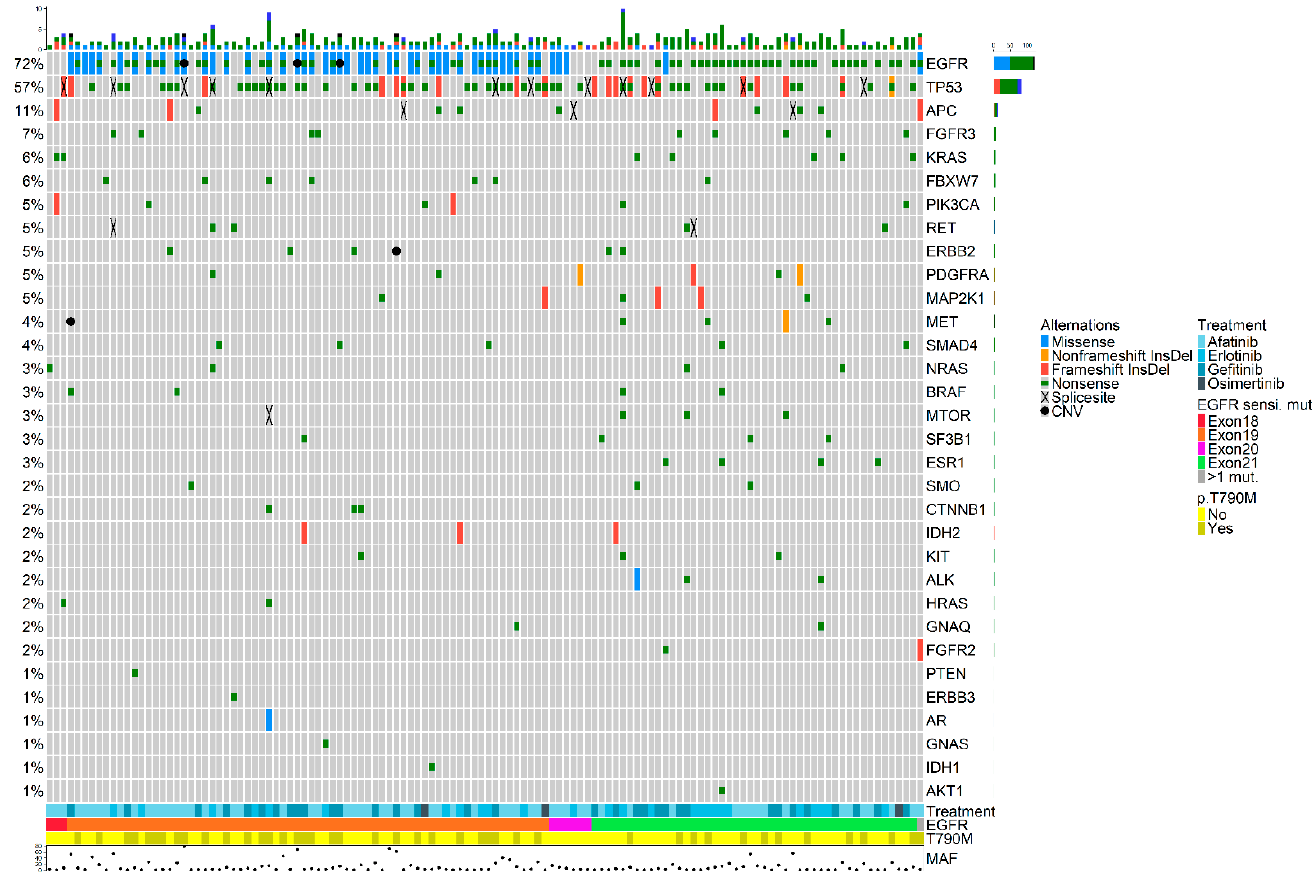
Figure 1. OncoPrint plot showing the distribution of genomic alterations detected in the plasma samples collected upon disease progression. Overview of genomic alterations (legend) in particular genes (rows) for each sample (columns). Missense mutations, non-frameshift deletions or insertions, frameshift deletions or insertions, nonsense mutations, splice site mutations, and CNVs are shown as green rectangles, blue rectangles, red rectangles, black crosses, orange rectangles, and a black dots, respectively. At the bottom of the plot, the following features are presented: first-line EGFR -TKI, type of original EGFR -sensitizing mutation, and detection of the p.T790M resistance mutation at disease progression. The maximum value of MAF from all detected variants is also shown. Co-occurring mutations were not associated with smoking history and did not have an impact on overall survival (OS). CNV: copy number variant; InsDel: insertion or deletion; MAF: mutated allele frequency.